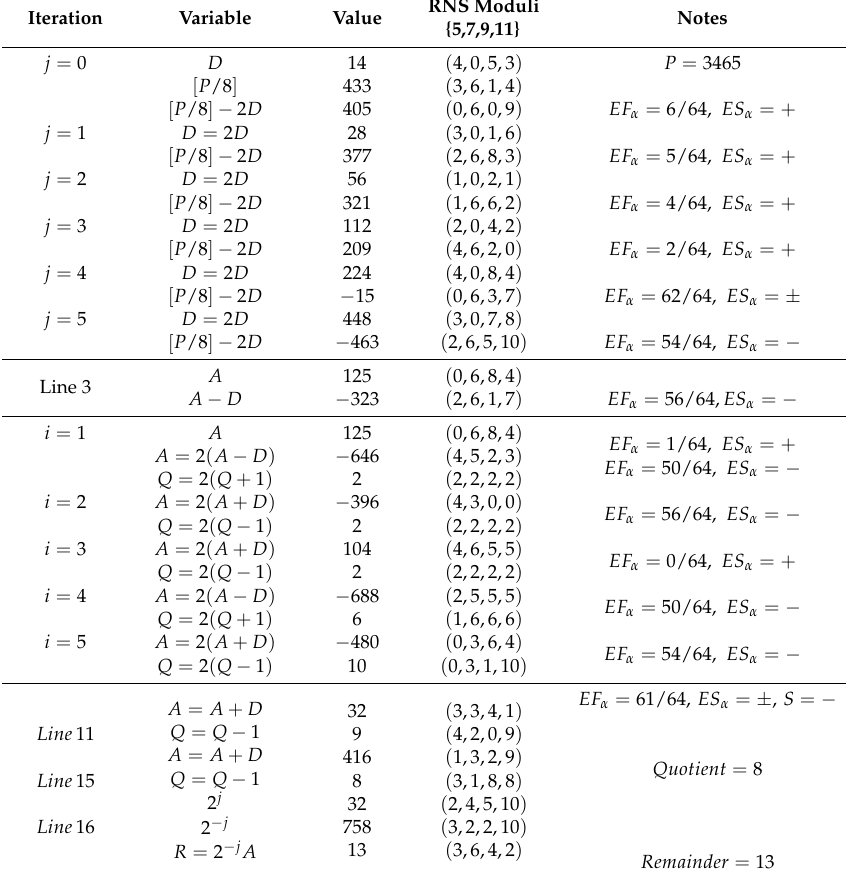
by algorithm [25]. 14